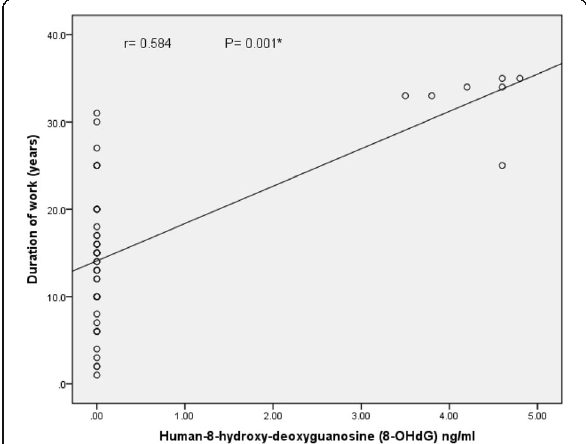
Fig. 6 Correlation between duration of work and Human